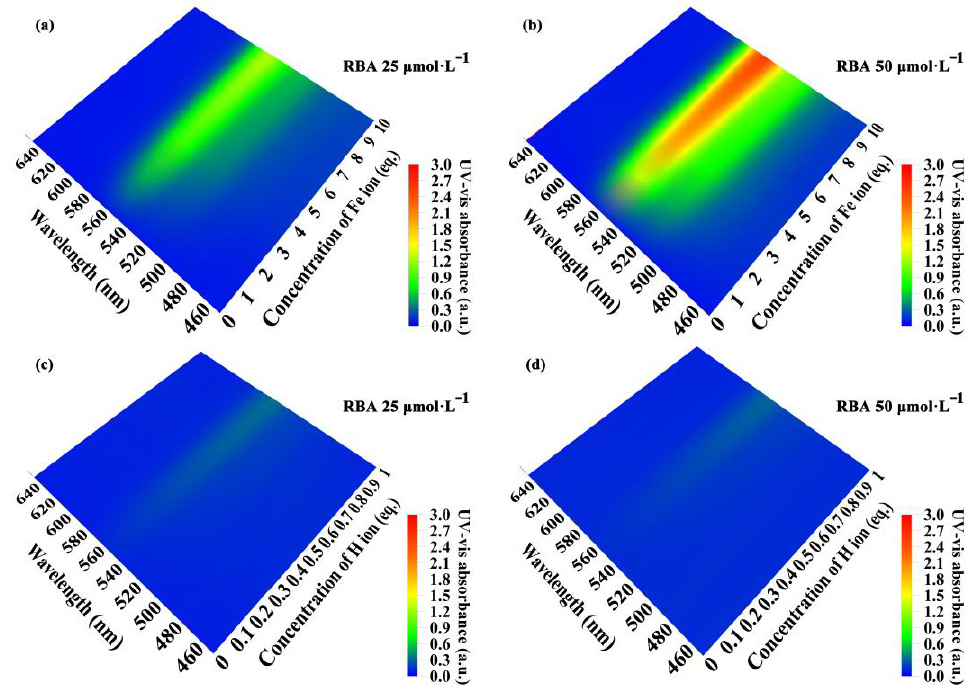
Figure 6. The ultraviolet-visible absorption behavior of RBA response to iron ion and proton, ( a ) RBA 25 µ mol · L − 1 , Fe 3 + , ( b ) RBA 50 µ mol · L − 1 , Fe 3 + , ( c ) RBA 25 µ mol · L − 1 , H + , ( d ) RBA 50 µ mol · L − 1 , H 2 + .